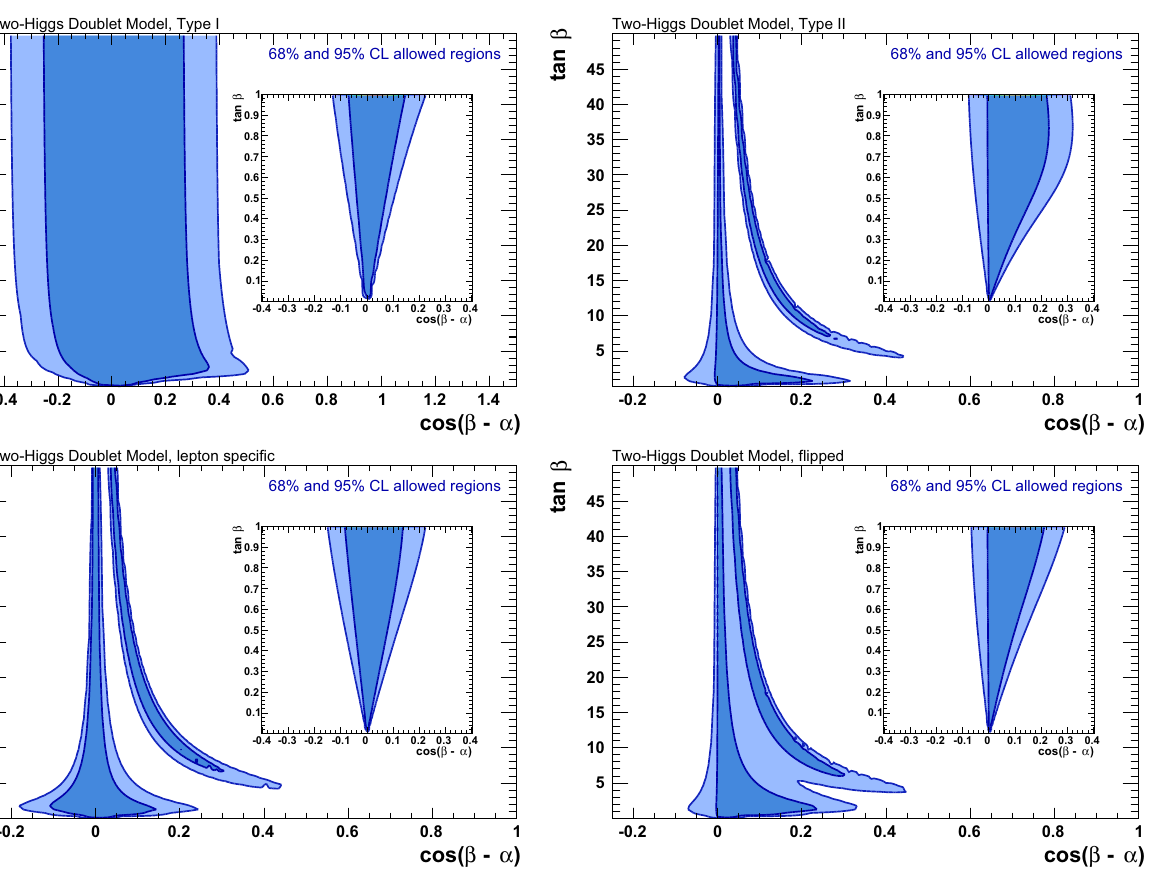
tan β versus cos (β − α) : Type-I (top left), Type-II (top right), lepton specific (bottom left) and flipped (bottom right) 2HDMs. The figure insets show a zoom of the region with tan β < 1